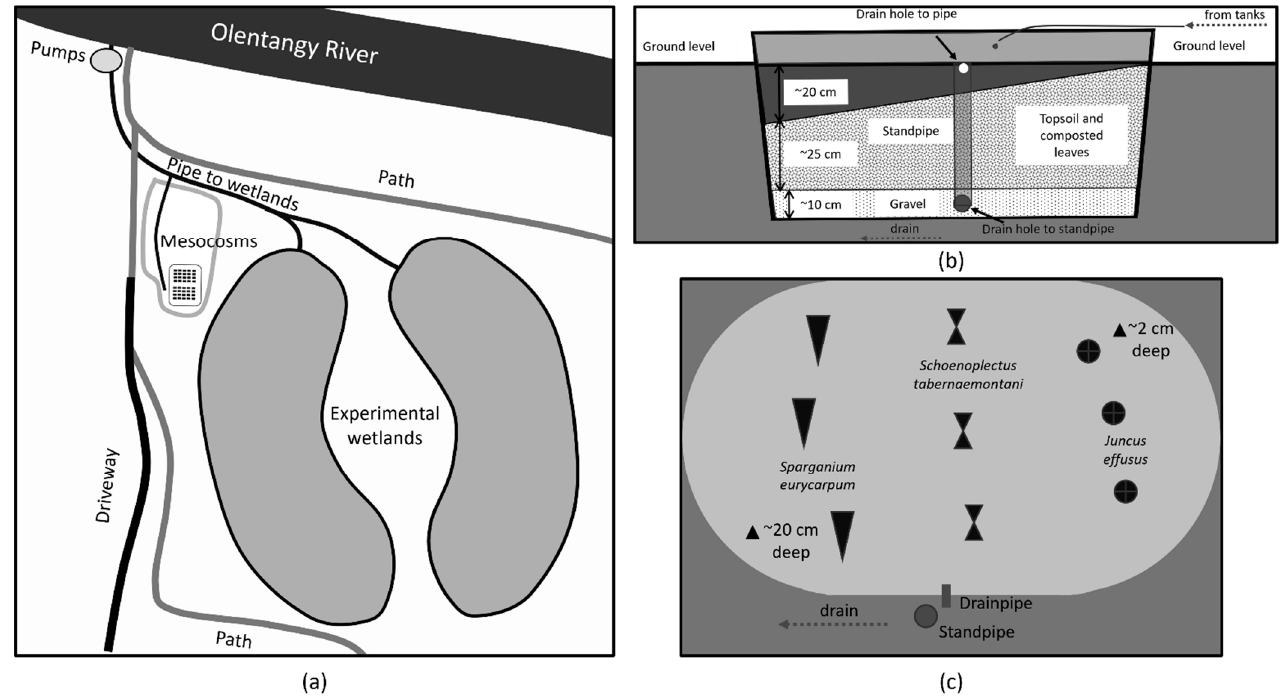
Figure 1. The site and mesocosm schematics: ( a ) an aerial schematic of the site; ( b ) a cross-section of a mesocosm, which illustrates the two drainage configurations; ( c ) a schematic of a mixed vegetation mesocosm from above. Each mesocosm is approximately 1 m 2 .